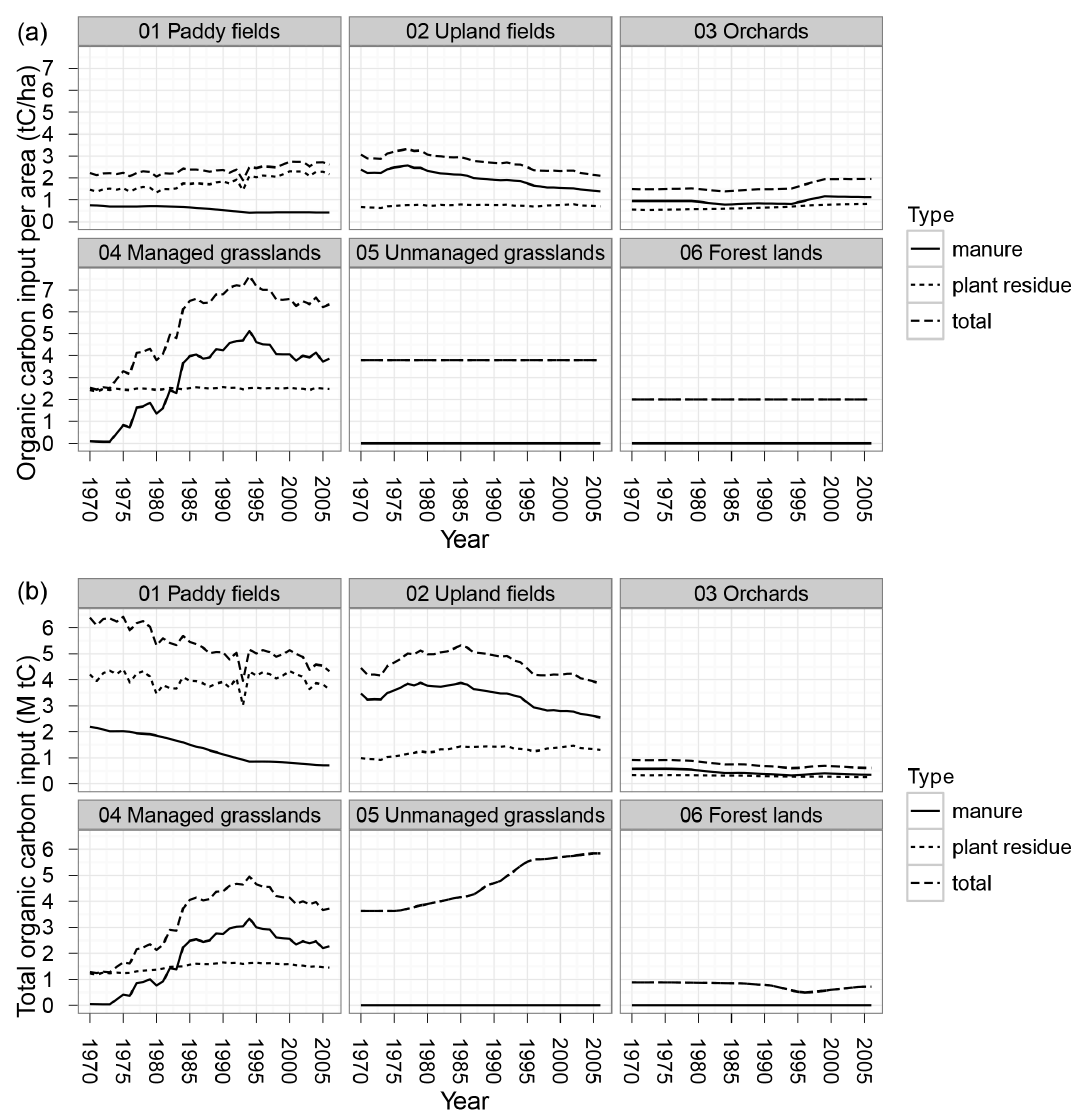
Figure 4. Input of organic carbon to soils via incorporation of plant residues and application of manure (including slurry and excreta), expressed as annual input rate per unit area of soils (a) and annual total sum (b) , in different land-use types during